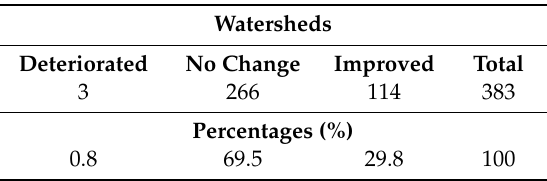
Table 4. Number and percentages of watersheds where the correlation between the actual and modeled flows improved (Fisher r to Z transform, α = 0.05) after running the SWYM accounting for cryospheric conditions (SWYM +